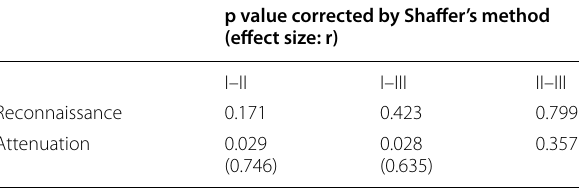
Table 17 p-values based on a comparison for each type